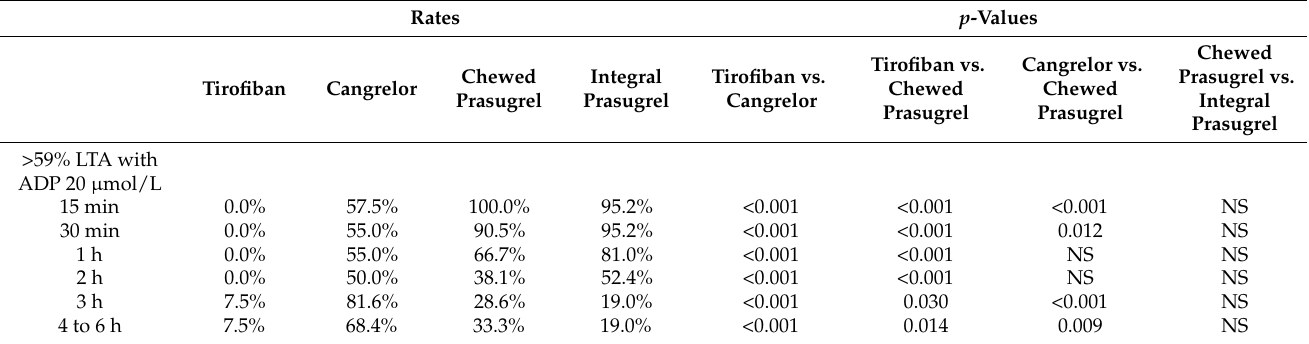
Table 3. Rates of high residual platelet reactivity (>59%) at Light Transmittance Aggregometry (LTA) after ADP 20 µ mol/L stimulation in FABOLUS FASTER trial